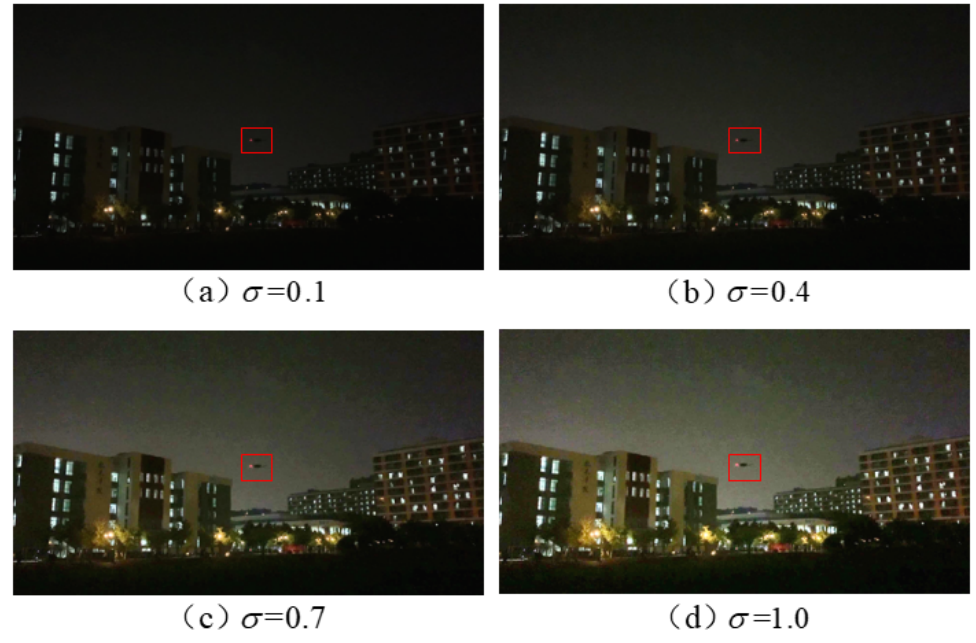
Figure 9. Enhanced results of Video 3 (containing the DJI Mavic 2 Pro obstacle object) at different σ